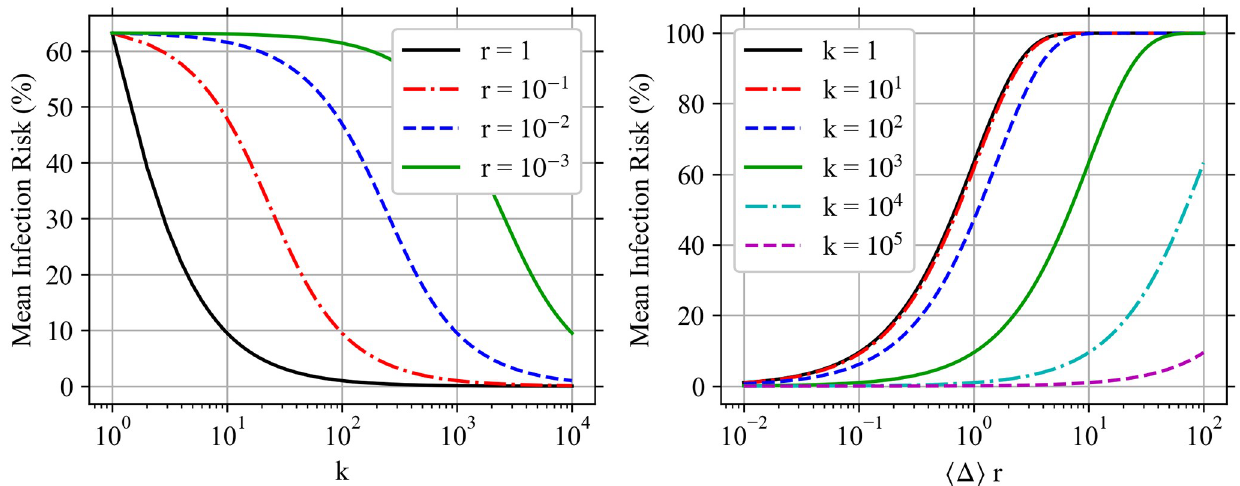
) using the modified exponential dose-response model when all infectious E